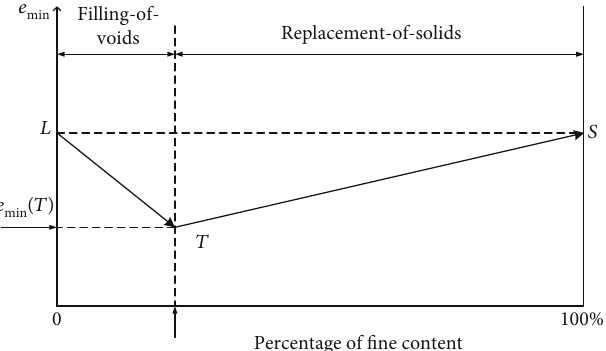
Figure 2: E ff ect of fi nes on binary packing of spherical particles in e